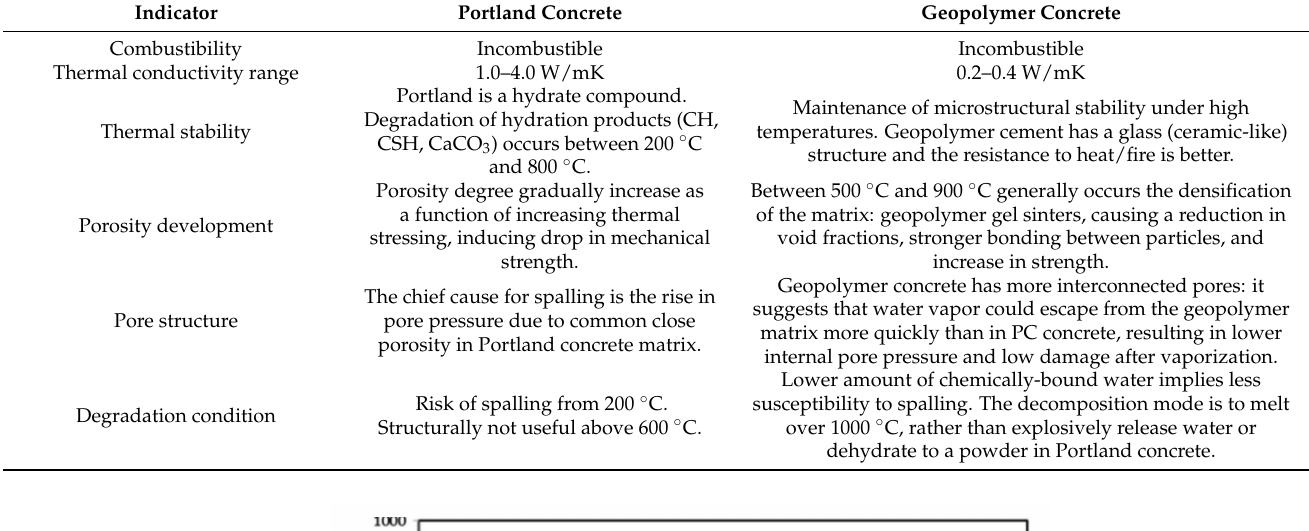
Table 6. Main observations of comparative analysis conducted by Lahoti et al. [96] about fire resistance properties of geopolymer and Portland concretes.